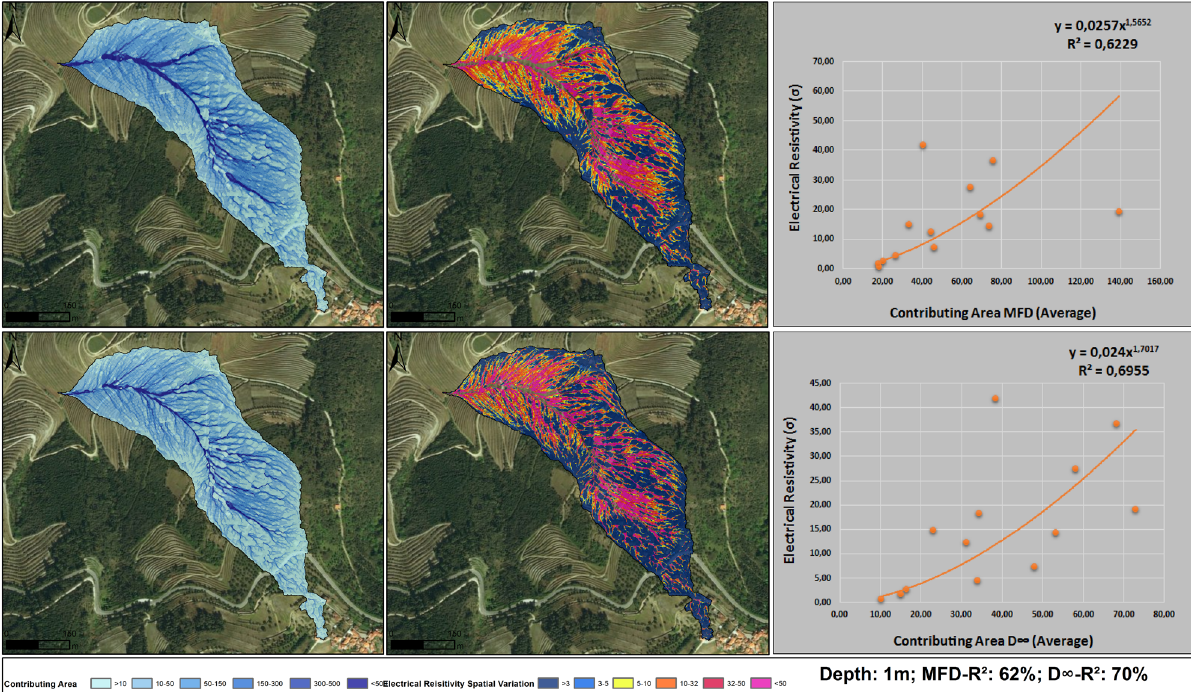
Figure 6: Soil electrical resistivity spatial variation at 1 meter of